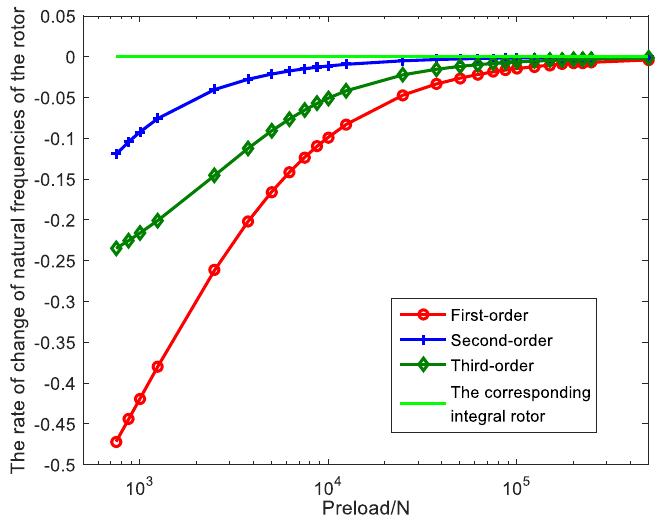
Figure 12. The rate of change of natural frequencies of rod-fastened rotor (RFR) considering the contact interface.